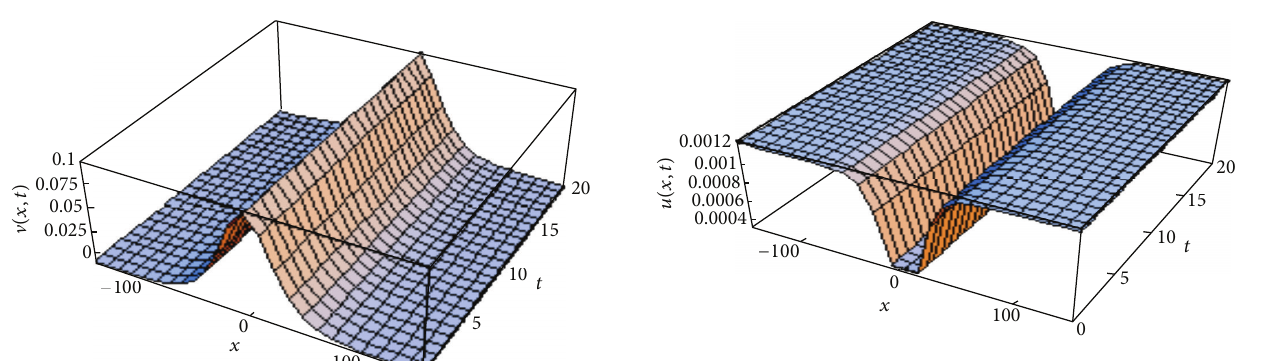
Figure 6: Approximate solution of FJM